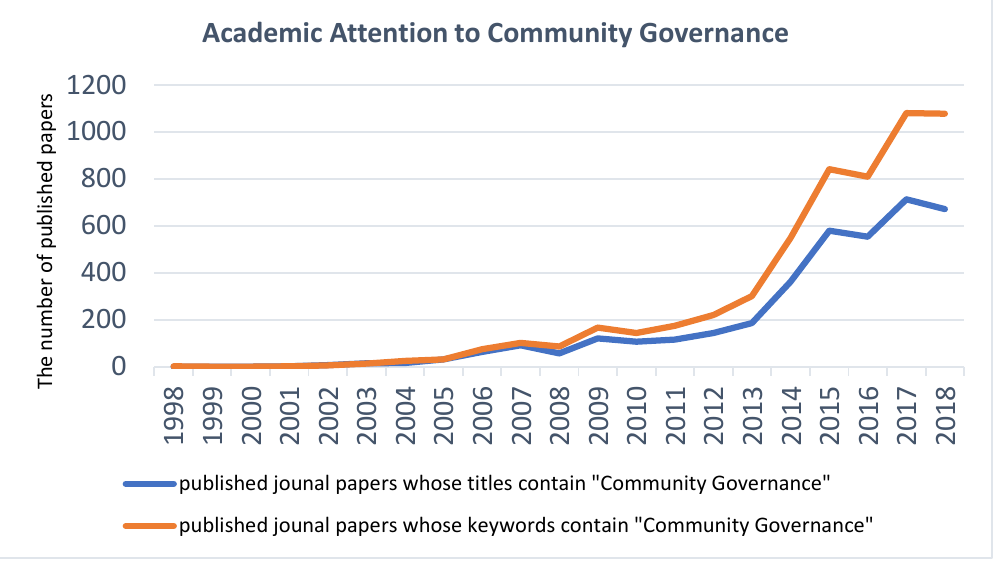
Fig. 2 . The number of published papers on “Community Governance” in China over the past two decades (developed by the authors, based on China National Knowledge Infrastructure,